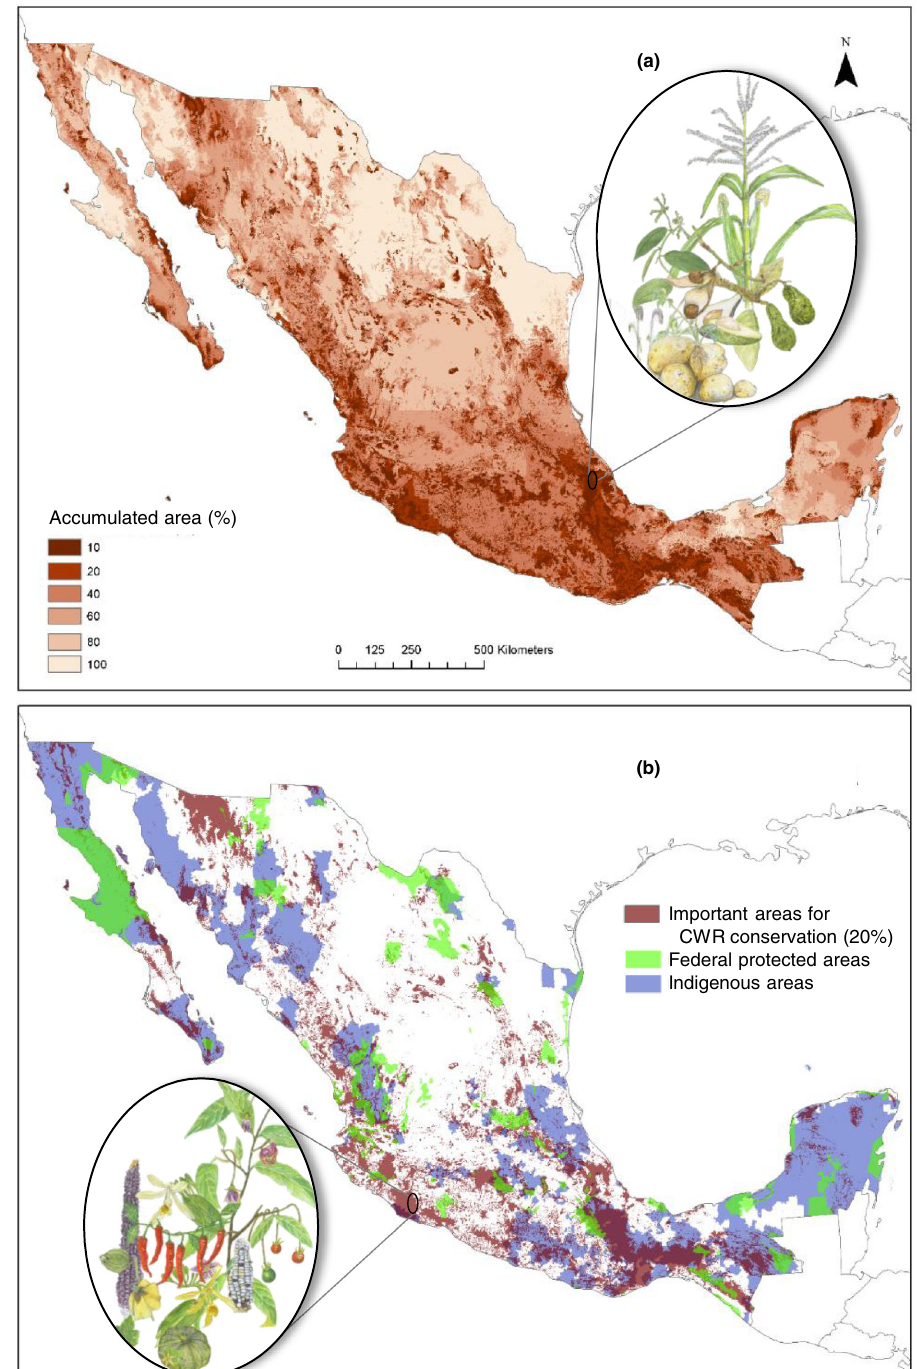
Fig. 5 | Results of the systematic conservation planning process for Mesoa- merican crop wild relatives in Mexico, based on the scenario considering potentialdistributionmodelssubdividedbyproxiesofgeneticdifferentiation, SDM*PGD (see Fig. 4, scenario iv), and including occurrence records for taxa withoutSDM,IUCNthreatcategories,andspeci fi chabitatpreferences(seetext for details). ( a ) Hierarchical landscape priority rank map, where the 10% most valuablefractioniswithinthemostvaluable20% fraction;themostvaluable20%is within the most valuable 30%; thus expressed as accumulated area. ( b ) Conserva- tion area proposal considering 20% of Mexico ’ s terrestrial area to maximize the representation of taxa and proxies of genetic differentiation (see Fig. 6). Federal